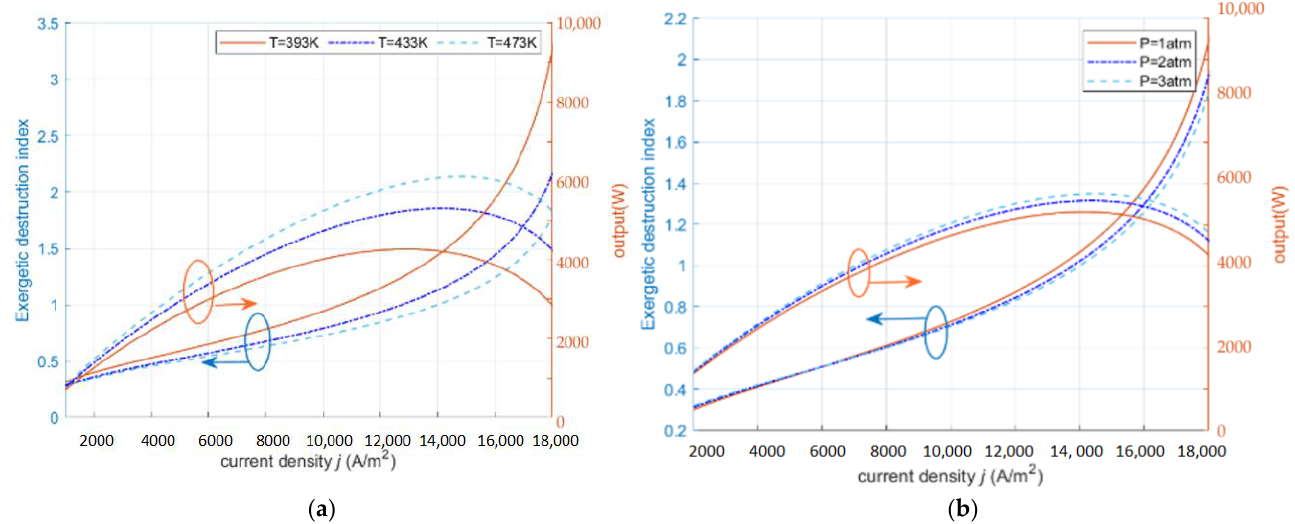
Figure 3. The effect of operating parameters on exergy destruction index and power density ( RH = 0.038%, t mem = 0.002 cm, DL = 10). ( a ) different T ; ( b ) different P .